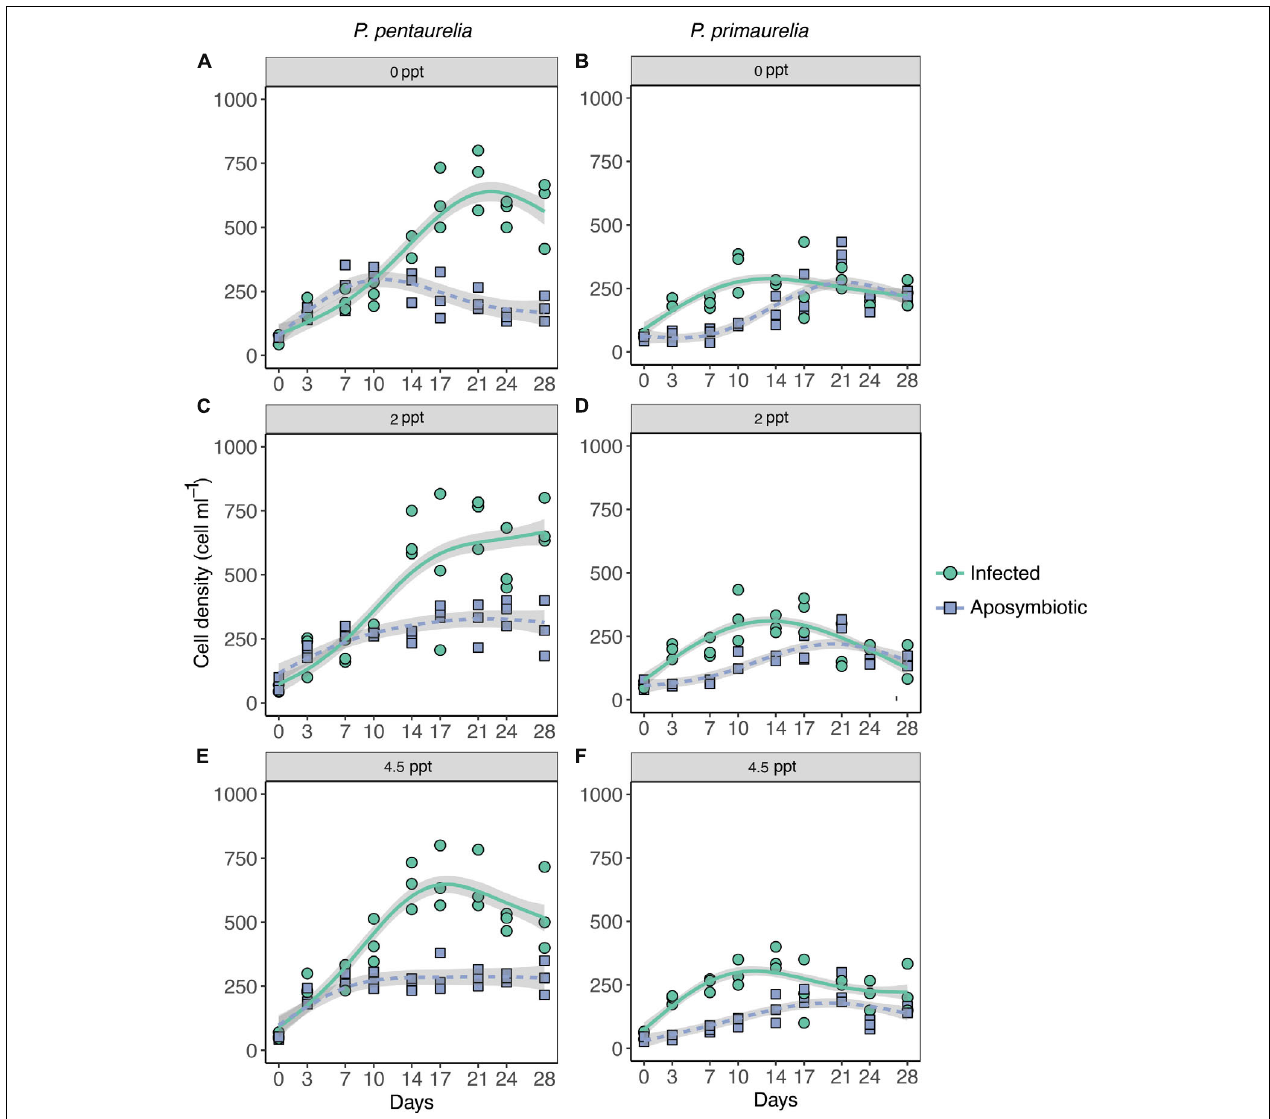
FIGURE 1 | Growth of Paramecium lines either infected with Ca. Megaira polyxenophila or aposymbiotic at different salinity concentrations over a period of 28 days. Paramecium pentaurelia YE9 infected (green line) with Ca. Megaira polyxenophila in comparison with the respectively symbiont-free line YE9AB (purple line) at 0 ppt salinity (A) , 2 ppt salinity (C) , and 4.5 ppt salinity (E) . Paramecium primaurelia LgJac infected (green line) with Ca. M. polyxenophila in comparison with the respectively symbiont-free (purple line) LgJacAB at 0 ppt salinity (B) , 2 ppt salinity (D) , and 4.5 ppt salinity (F) . Data points represent three experimental units and the growth curve is represented by the mean of these three